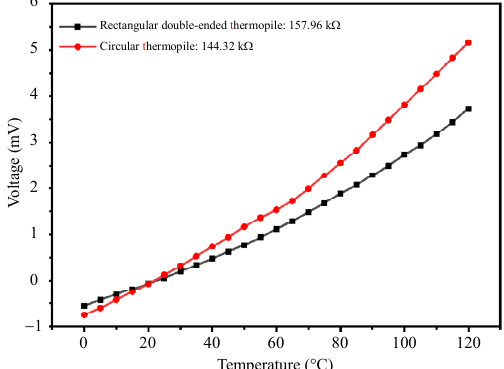
Fig. 12 Temperature response characteristics of the thermopile for two configurations.